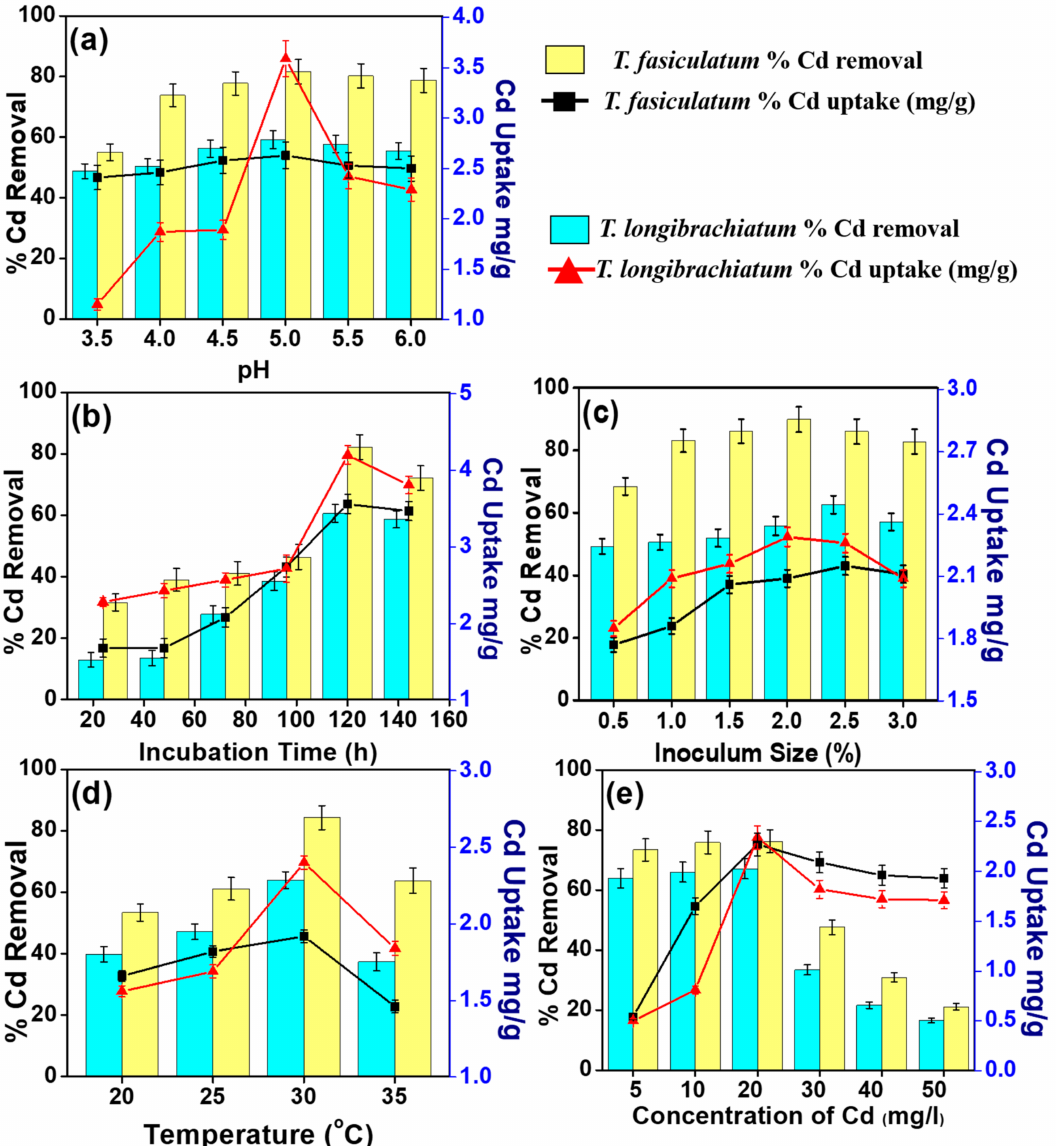
Figure 1. E ff ect of operational parameters on the Cd 2 + removal e ffi ciency by T. fasciculatum and T. longibrachiatum ( a ) pH ( b ) Incubation Time ( c ) Inoculum Size ( d ) Temperature ( e ) Concentration of